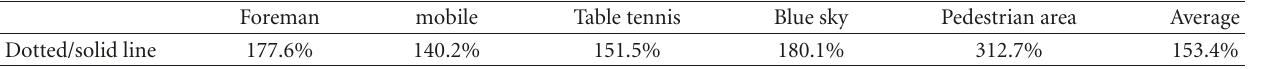
Table 4: Ratio of the di ff erence along the dotted line scan over that along the solid line scan.